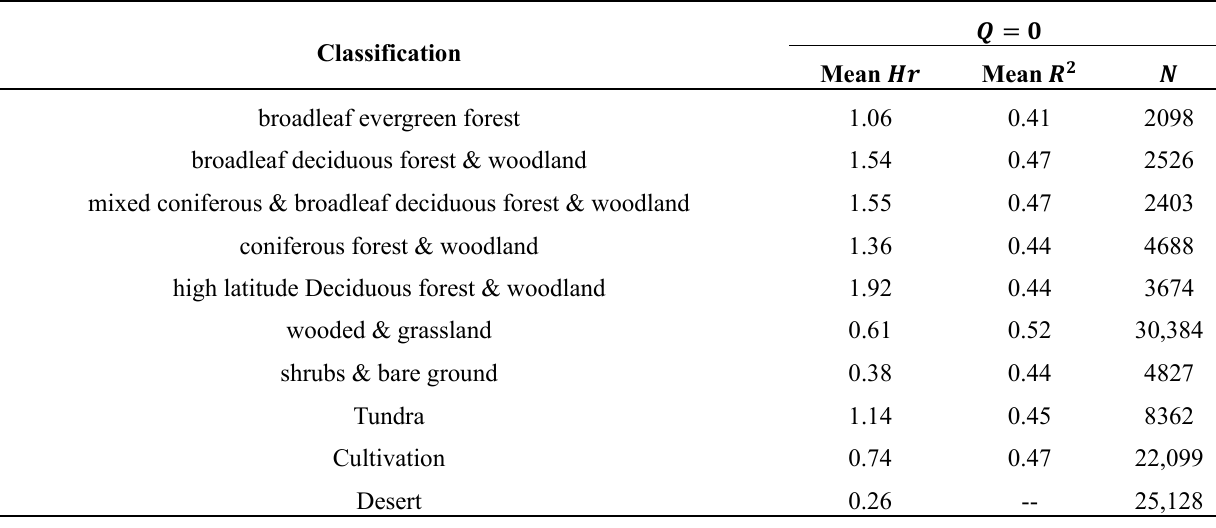
Table 2. Mean values of (cid:1834)(cid:1870) and of the (cid:1844) (cid:2870) for the linear regression between (cid:1853) ∗ and NDVI for a variety of biomes as defined in [43]. (cid:1834)(cid:1870) and (cid:1844) (cid:2870) values were averaged over all pixels corresponding to the different biomes ( (cid:1840) (cid:3404) number of pixels considered in the computation).